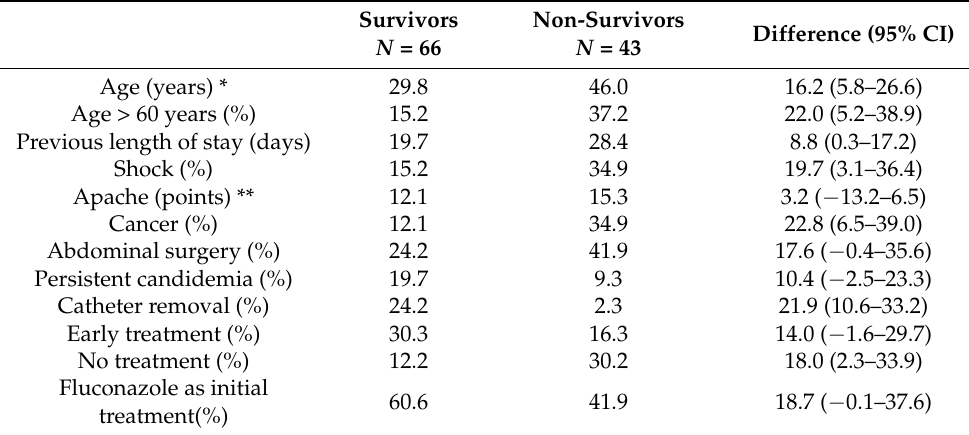
Table 3. Characteristics of patients according to the final outcome (survival).